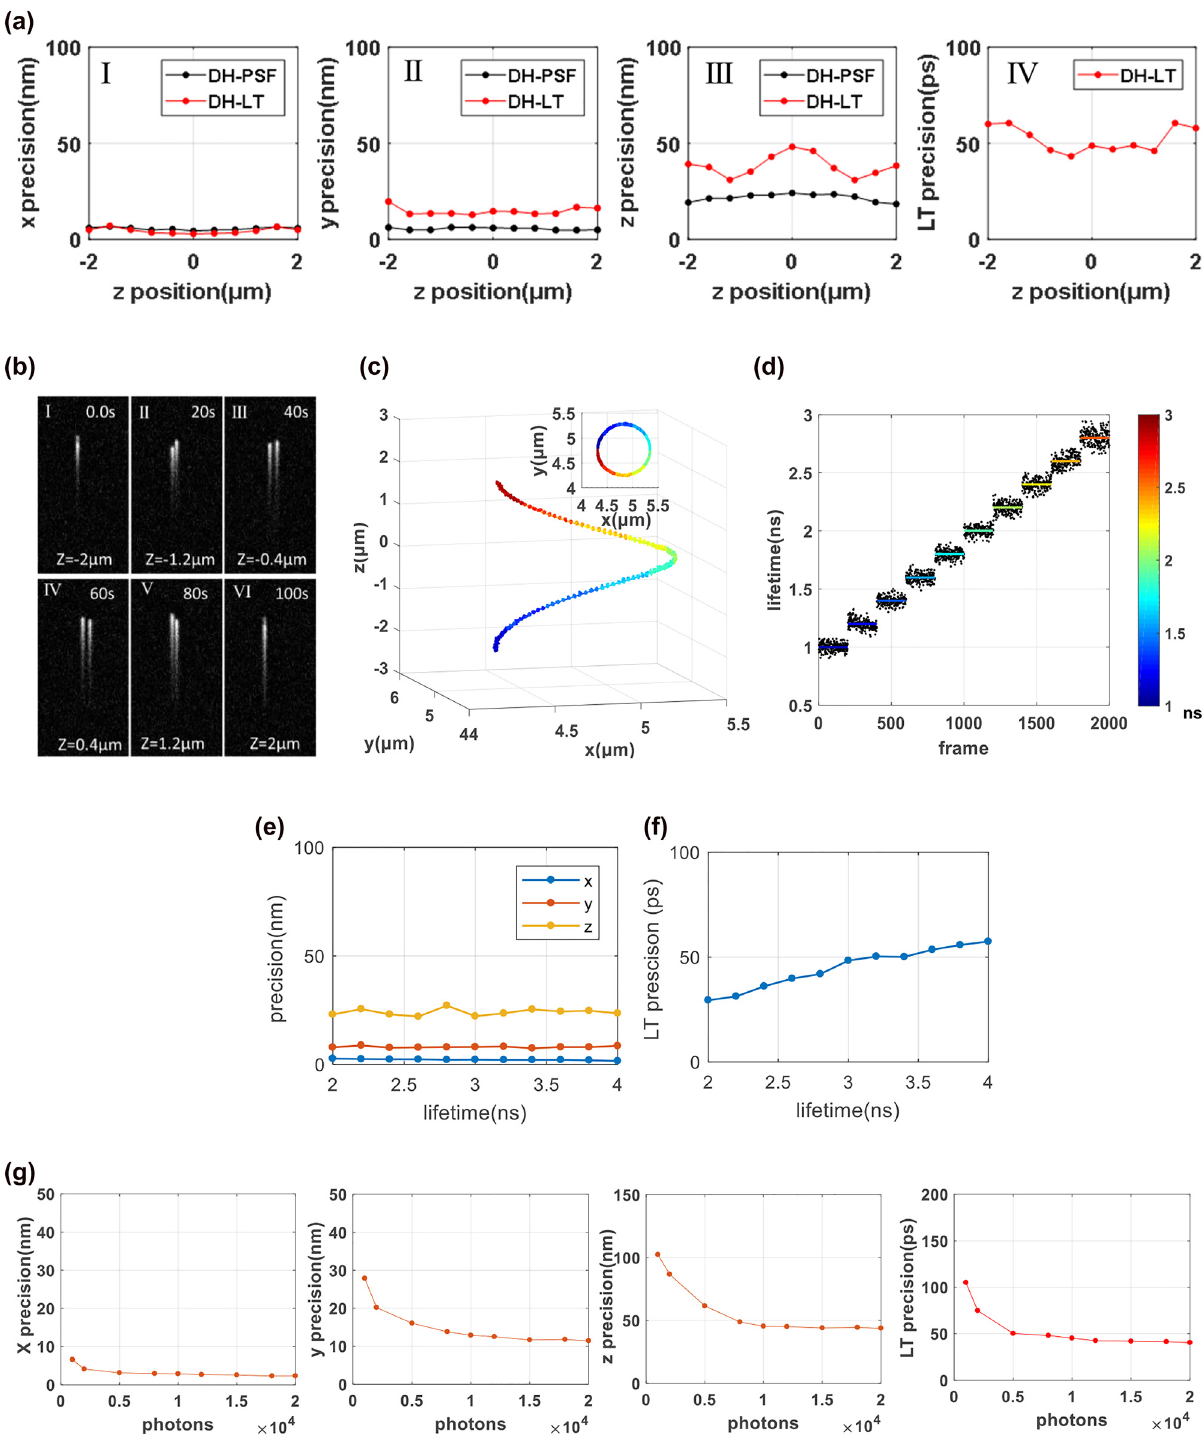
Figure 2: Numerical simulations of the 4D-tracking method. (a) Localization precisions in the x , y , and z directions (I) – (III) and accuracy of the fl uorescence lifetime measurements (IV) analyzed statistically at different z positions (DH-LT, red dots). For comparison, localization precisions of conventional DH-PSF obtained with the same totalnumberofphotonsarealsopresentedforthesame z positions(DH-PSF,blackdotsin(I) – (III).(b)Siximagesatsixtimepointstrackingthe movement of a fl uorescent emitter following a spiral trajectory and experiencing step-wise increases in fl uorescence lifetime. It is apparent that sometimes the two lobes are separated (II) – (V) and sometimes they are overlapped (I), (VI). (c) Estimated localizations at timepoints are markedasdotswithpseudocolorswhichre fl ectthecorresponding fl uorescencelifetime.(d)Ten fl uorescencelifetimesattensegmentsofthe trajectoryareanalyzedfurther.(e)Spatialprecisionplottedagainstlifetime.(f)Lifetimeprecisionplottedagainstlifetime.(g)Localizationand lifetime precision at z = 0 μ m, as a function of the number of total photons ranging from 1000 – 20,000